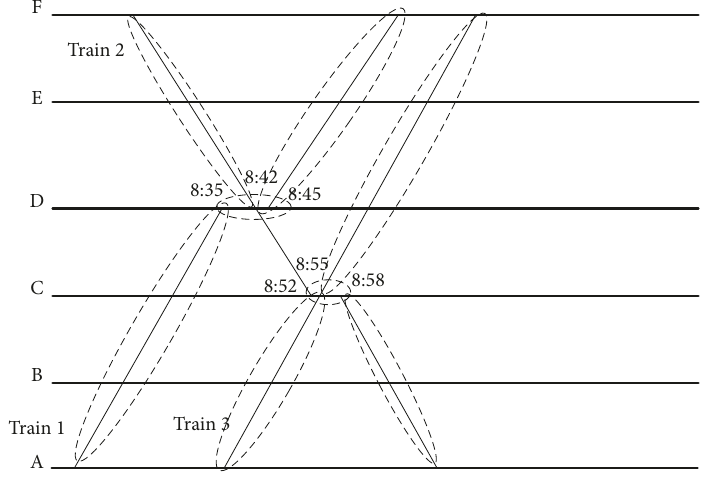
Figure 4: Illustration of the aggregation